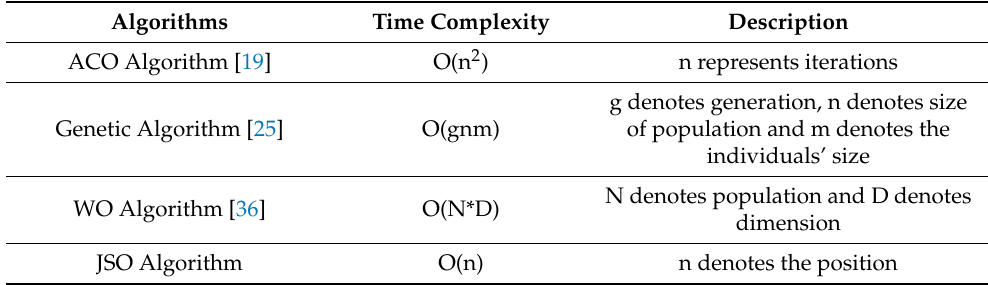
Table 4. Analysis of Time